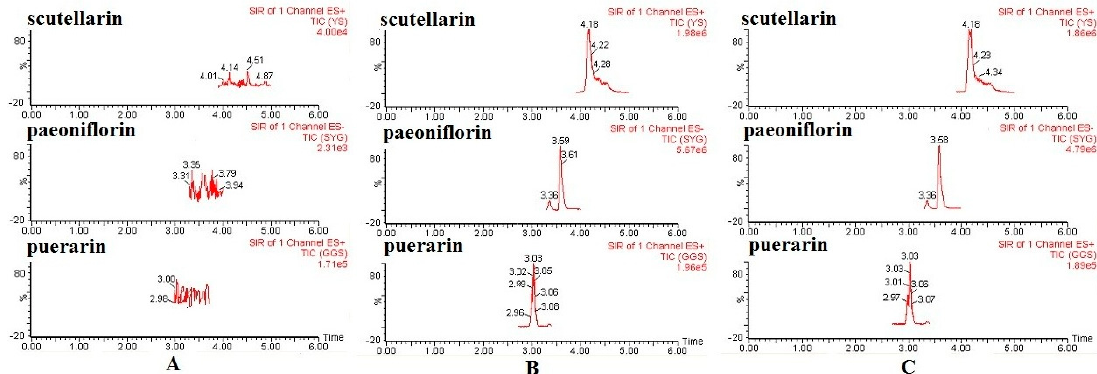
Figure 3. Typical selected ion recording (SIR) chromatograms obtained from analyses of blank plasma ( A ); blank plasma spiked with the scutellarin, paeoniflorin, and IS ( B ); and plasma samples from normal rats 15 min following the intravenous administration of Xin-Shao formula extracts ( C ).